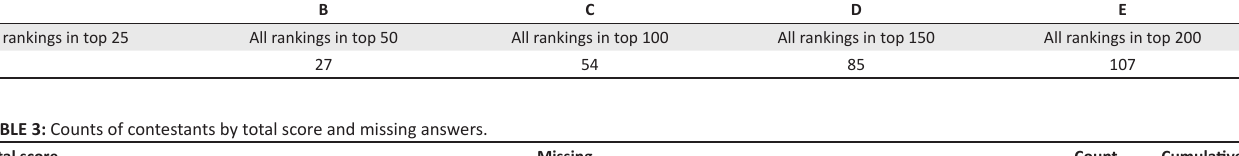
TABLE 2: Cumulative counts of contestants in rank groups on four analysis routines. A B